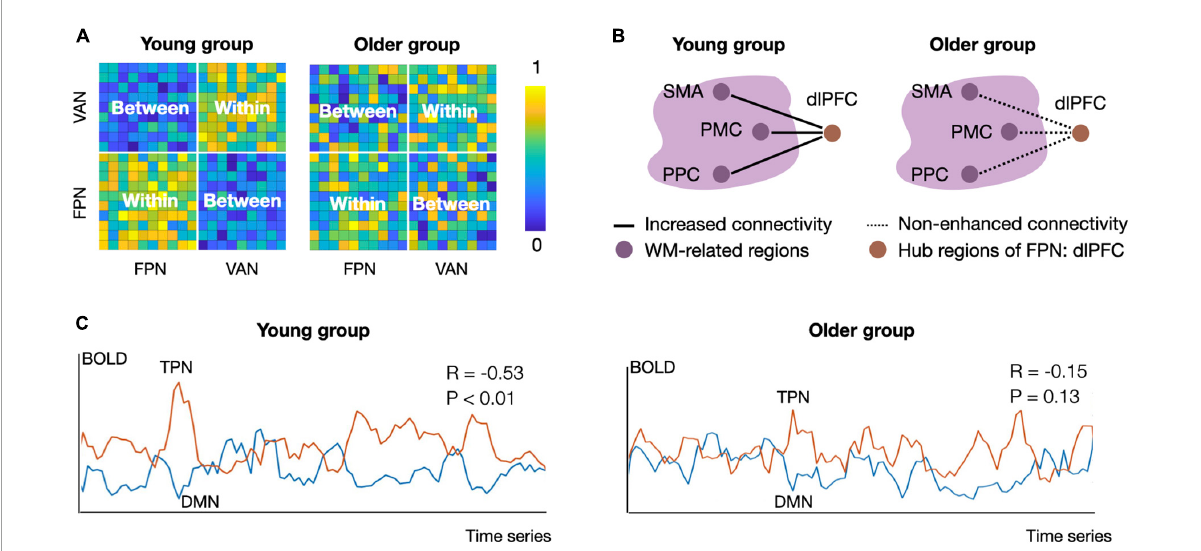
FIGURE1 Schematic diagram of group differences in functional segregation, integration, and antagonism between young and older adults. (A) Functional segregation of the frontoparietal network (FPN) and ventral attention network (VAN) in the resting state. The intra-network connectivity in the young group is tightly connected, but the inter-network connectivity is weak. The connectivity pattern changes in older adults, showing decreased intra-connectivity and increased inter-connectivity of the FPN and VAN, suggesting decreased functional segregation of the task positive network (Chan et al., 2014; Zonneveld et al., 2019). (B) Functional integration in task processing. During the N-back task, the young group showed increased connectivity between the FPN hub (i.e., the left dlPFC) and working-memory-related regions from 1-back to 3-back conditions. Nevertheless, older adults did not show load-dependent connectivity enhancement between these regions, suggesting a decline in functional integration during aging (Nagel et al., 2011). The solid lines reflect increased connectivity strength, and the dotted lines indicate no load-dependent connectivity enhancement. Working-memory-related regions were located in the big bubble with purple color. (C) Functional antagonism between the TPN and DMN. The mean activity patterns of the TPN and DMN are predominantly negatively correlated in the younger group, while this correlation is absent in the older group. Panel A and C used simulated data to illustrate published findings (Nagel et al., 2011; Chan et al., 2014; Geerligs et al., 2015; Ferreira et al., 2016; Zonneveld et al., 2019). The connectivity matrix in panel (A) and connectivity strength in panel (C) were calculated by Pearson correlation. Within, intra-network connectivity; Between, inter-network connectivity; DMN, default mode network; TPN, task positive network; FPN, frontoparietal network; VAN, ventral attention network; SMA, supplementary motor area; PMC, premotor cortex; PPC, posterior parietal cortex; dlPFC, dorsolateral prefrontal cortex; WM, working